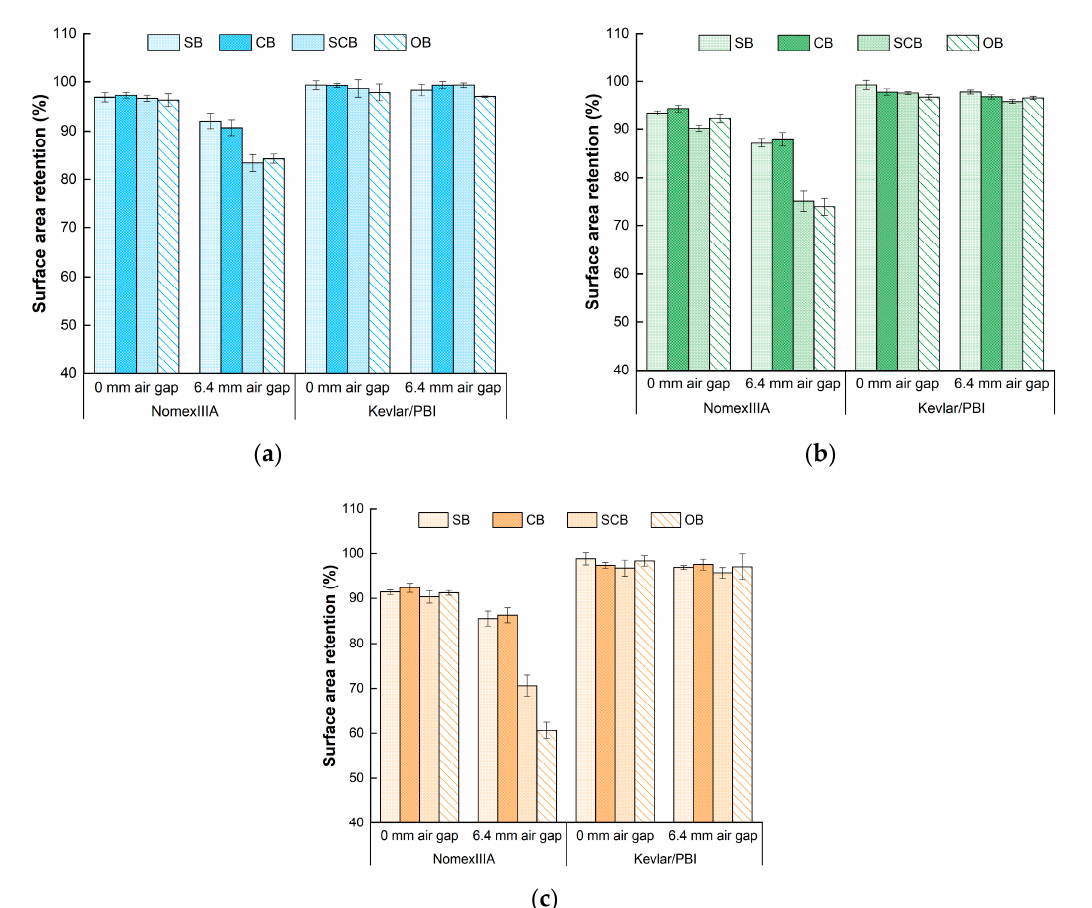
Figure 4. Surface area retention under the heat flux of: ( a ) 30 kW/m 2 ; ( b ) 40 kW/m 2 ; ( c ) 50 kW/m 2 .SB—standard boundary; CB—confined boundary; SCB—semiconfined boundary; OB—open boundary.